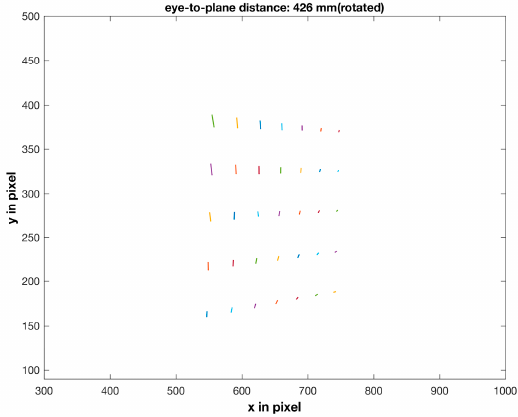
Figure A3. Map of disparities for a target plane rotated and placed at 426 mm from the observer.